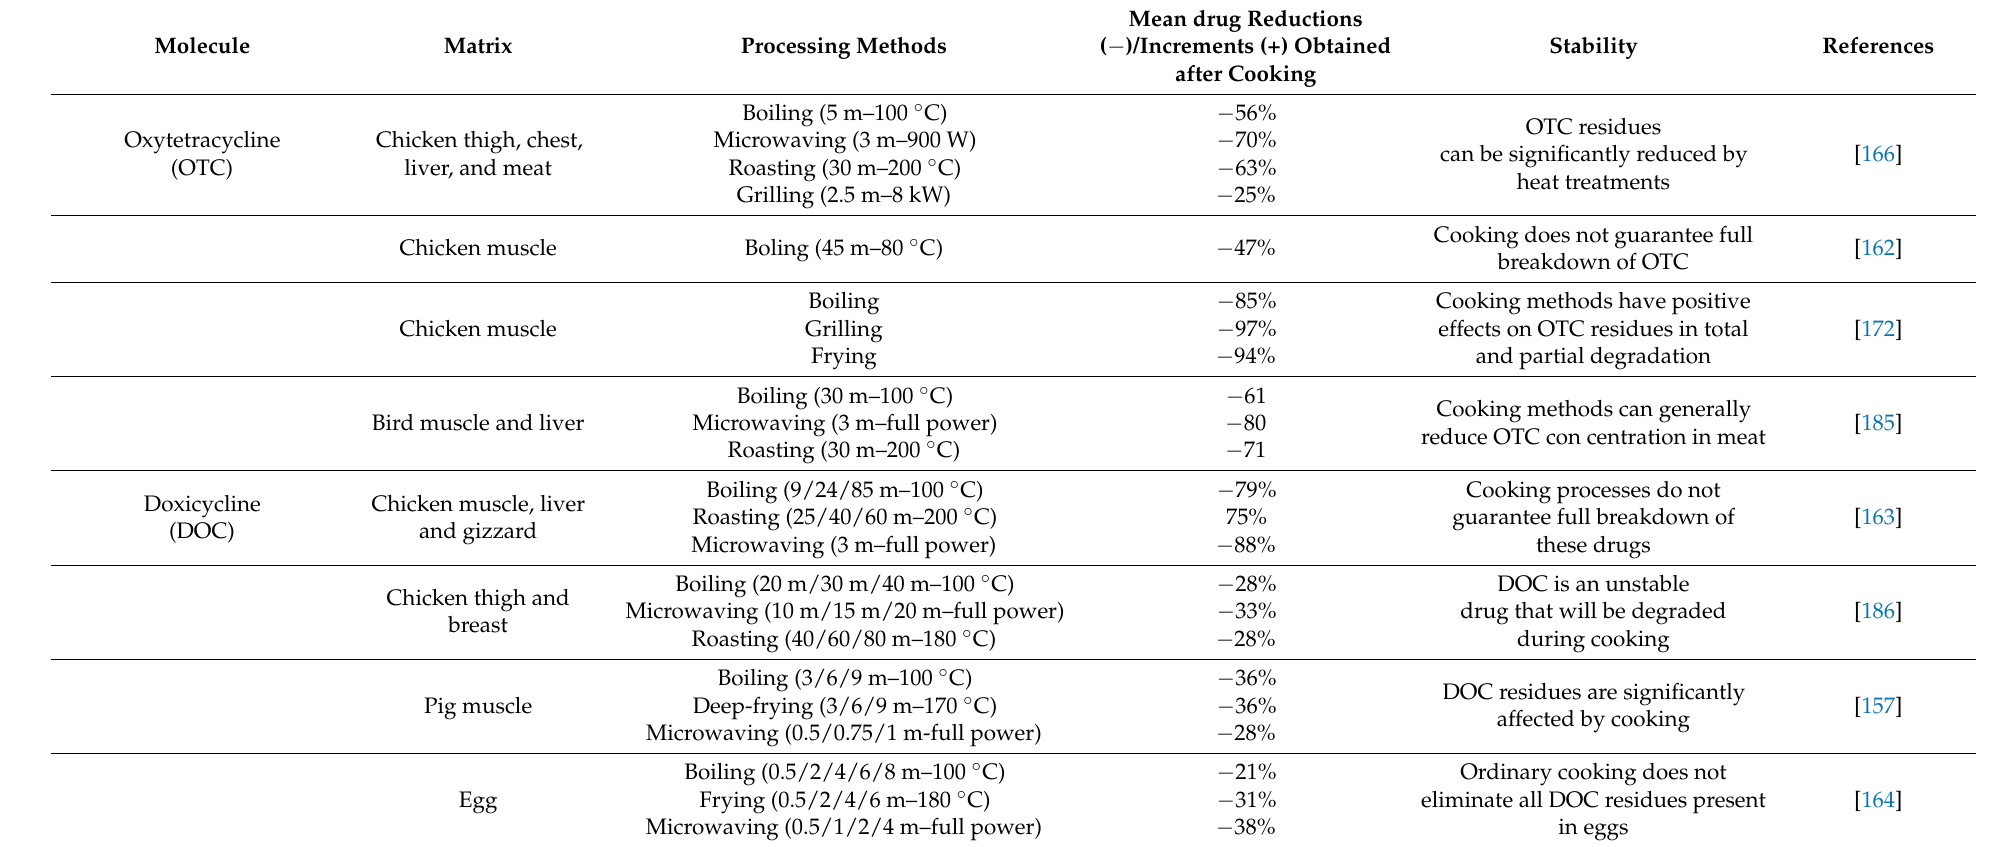
Table 2. Veterinary drug residue stability in different animal tissues cooked by common heat treatments reported in the